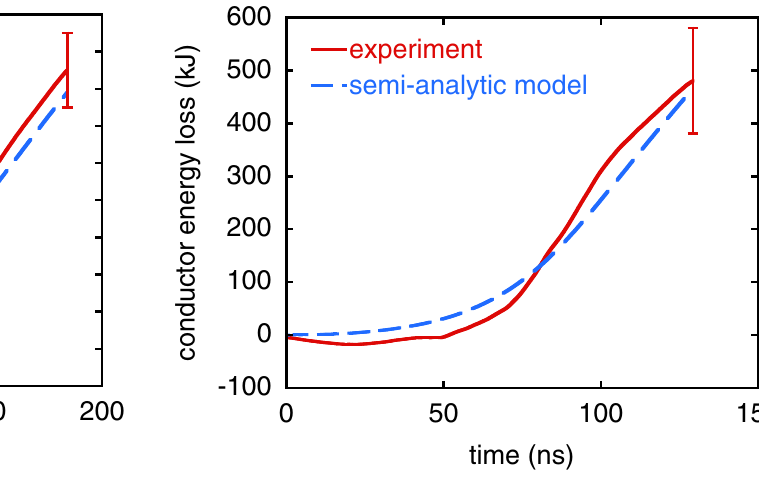
FIG. 6. (Color) Comparison of the measured conductor energy loss on Z-shot 532 with the prediction of the semianalytic model, as given by Eq. (35). The conductor system used as the load on this shot is that illustrated by Fig. 3. The plot includes a representative error bar.